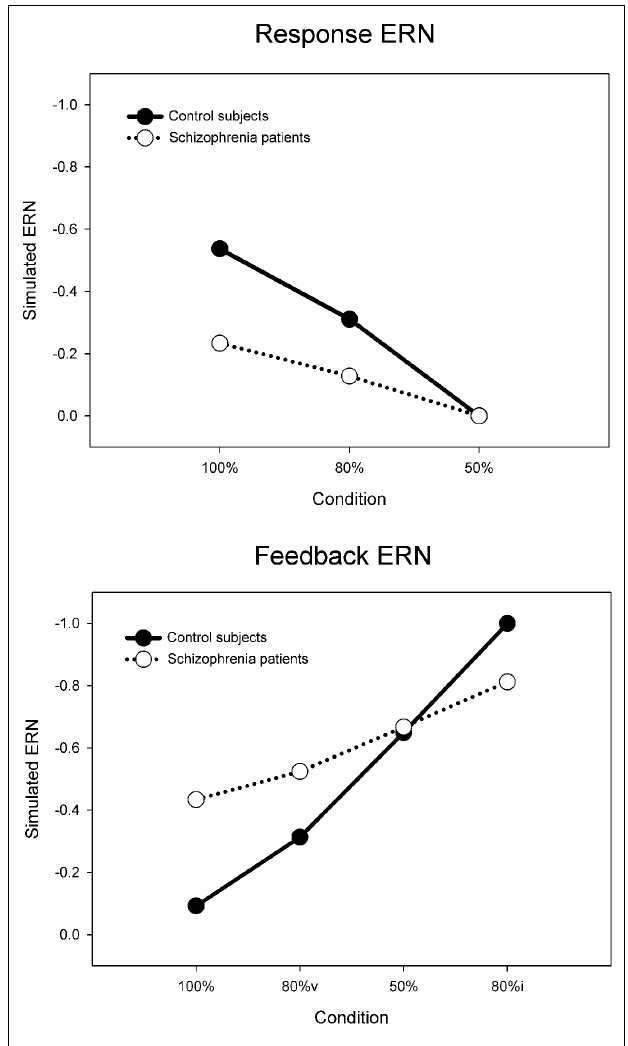
FIGURE 7 | Simulated control (default model) and schizophrenia (maximum value model) ERN difference wave data for the probabilistic learning task, for the response ERN (top) and feedback ERN (bottom). Note that “80%v” and “80%i” correspond to 80% condition trials with either valid or invalid feedback, respectively.